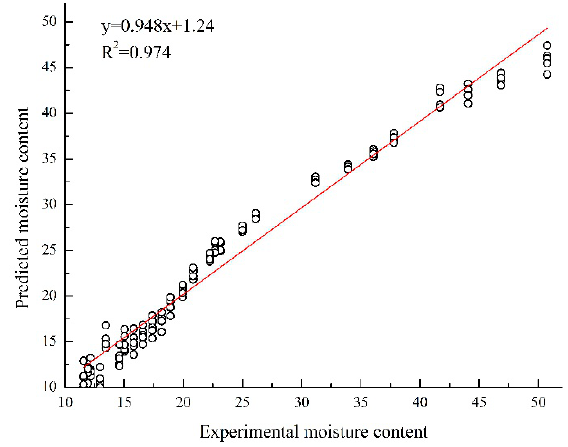
Figure 6. Prediction fitting curve of BP neural network.